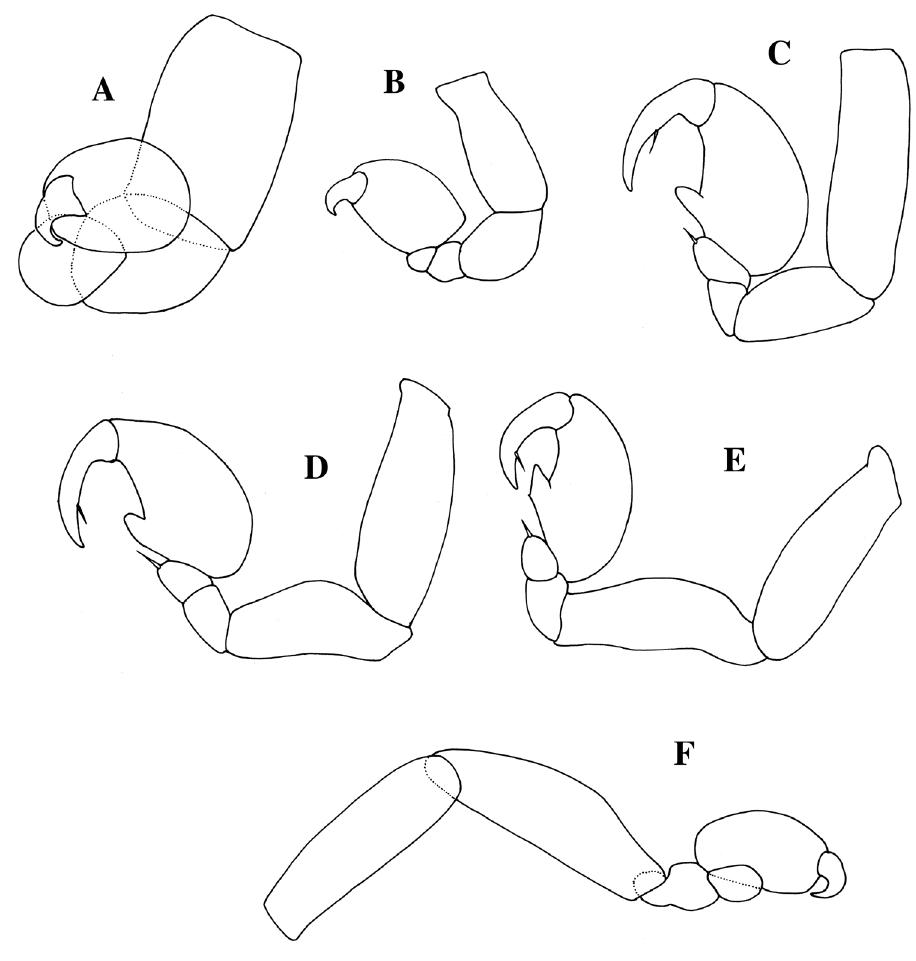
Figure 4. Aspidophryxus izuensis sp. n., A holotype female B–F allotype male (KMNH IvR 500911): A left fifth pereopod, dorsal B left first pereopod, lateral; C left second pereopod, lateral D left fifth pereo- pod, lateral E left sixth pereopod, lateral F left seventh pereopod, medial. Scale bar 100 µm. margin of the cephalon exceeding anterior margins of lateral lamellae in female; pleon unsegmented, vermiform, very long in female; uropod composed of protopod and in- ner and outer ramus in